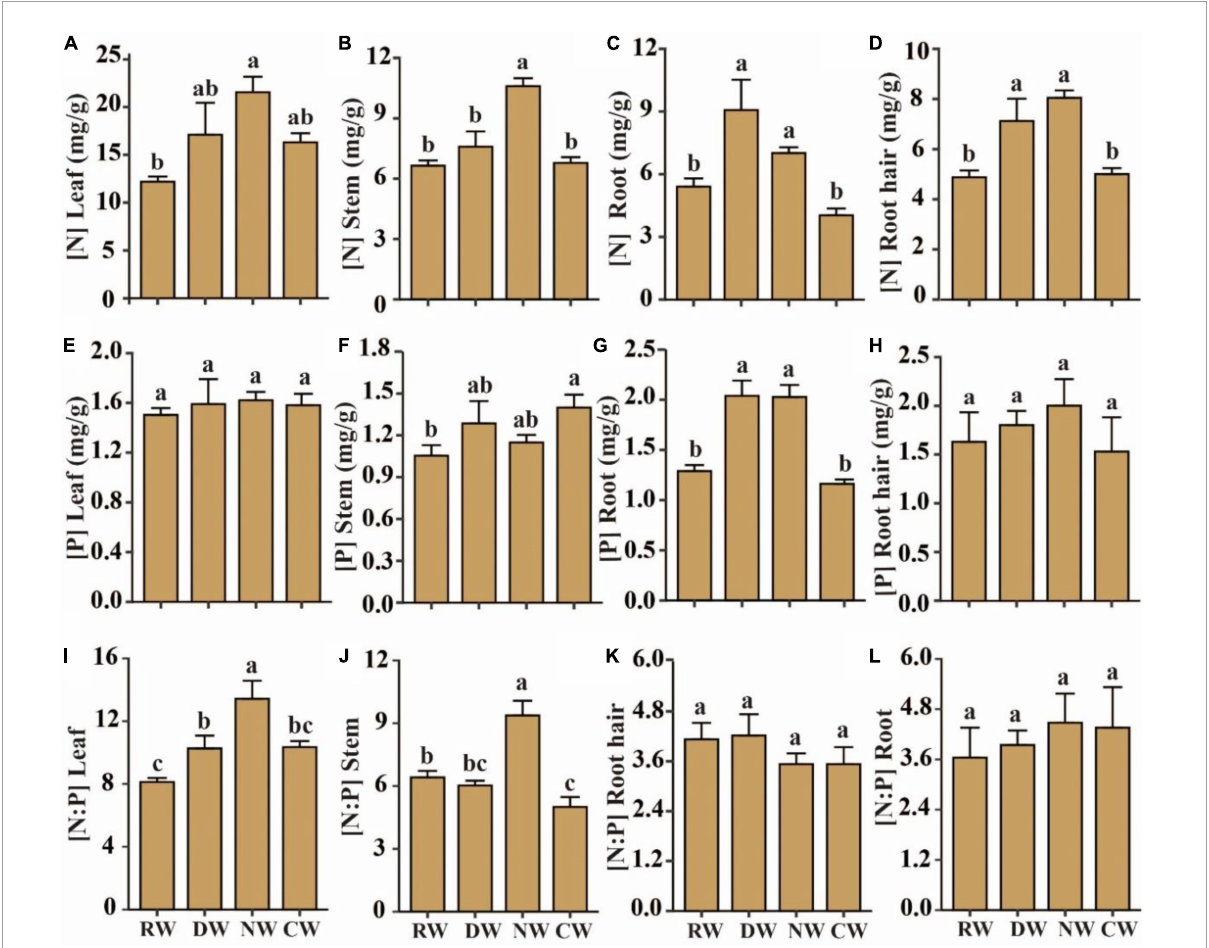
FIGURE3 Effects of agricultural intervention on N and P stoichiometry of plant tissues. (A–D) Plant tissue N content; (E–H) plant tissue P content; (I–L) plant tissue N and P stoichiometry. RW, reference wetlands; DW, drained wetlands; NW, nutrient-rich wetlands; CW, cultivated wetlands. Error bars represent ± SE. Different letters indicate significant differences between sites ( p <